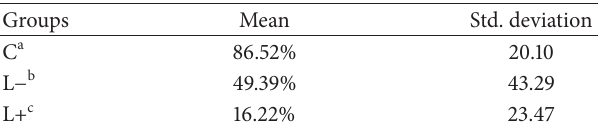
Table 2: Mean of percentage of dye penetration and standard de- viation in each